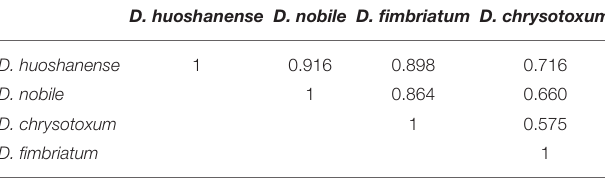
TABLE 7 | Similarity evaluation based on the HPLC fingerprints of the four Dendrobium